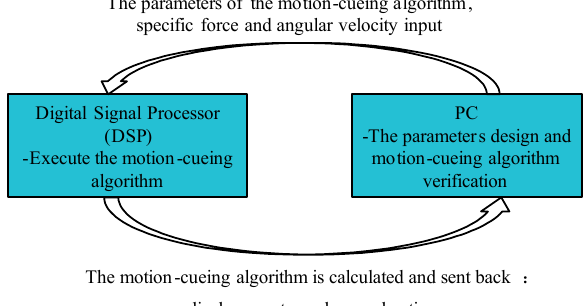
Figure 6. The relationship between the DSP and PC.